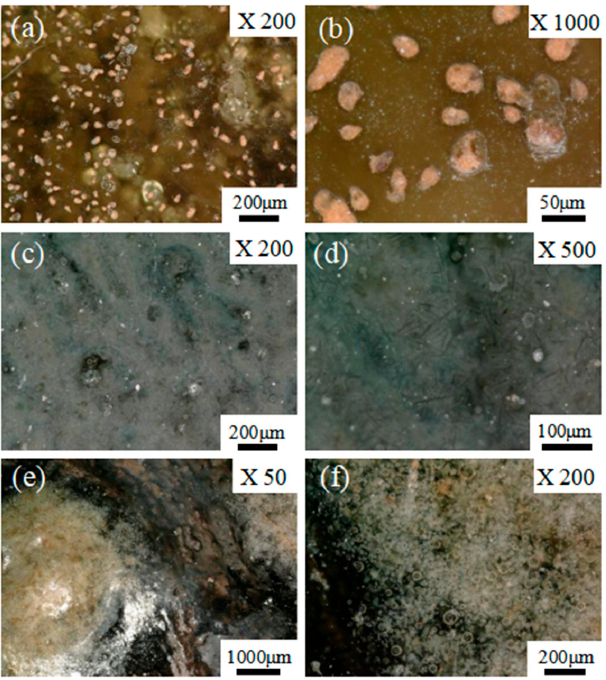
Figure 3. Surface morphology of three analyzed samples glaze: ( a , b ) JZ-07 tea-dust-glazed porcelain; ( c , d ) JZ-16, grey-glazed porcelain; and ( e , f ) JZ-14, pearl-glazed porcelain.